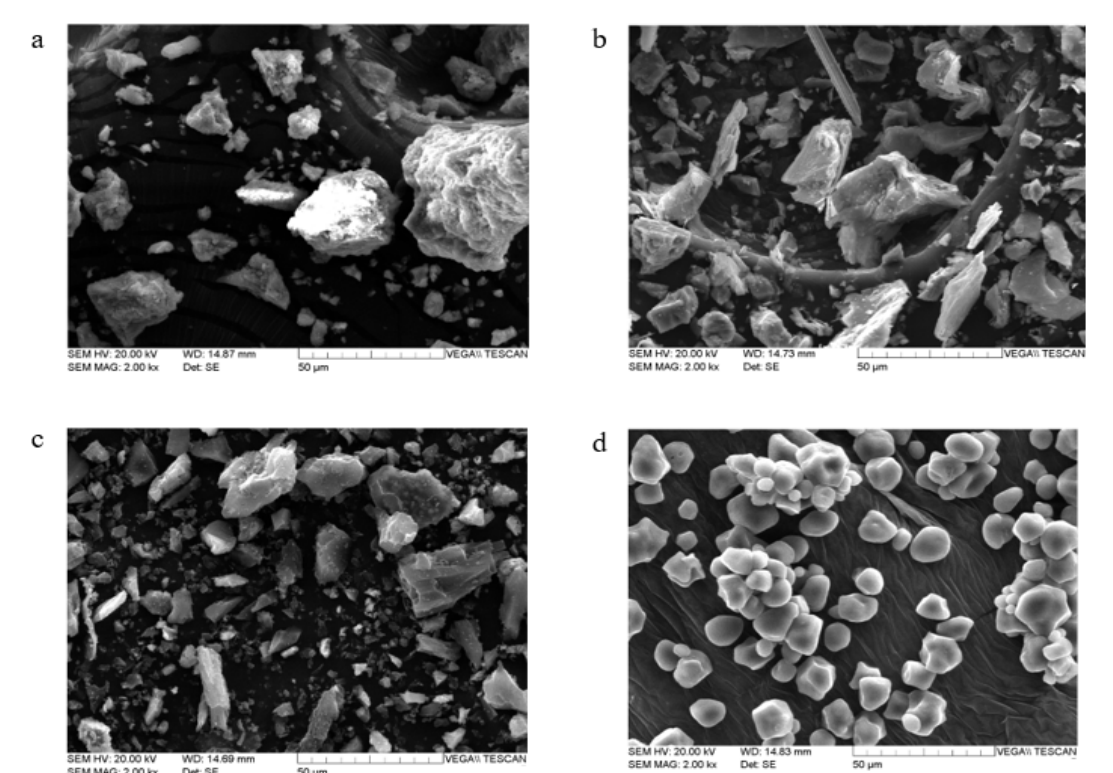
Figure 1. Scanning electron microscopy (SEM) images of ( a ) bentonite, ( b ) talc, ( c ) activated carbon, and ( d ) cornstarch.